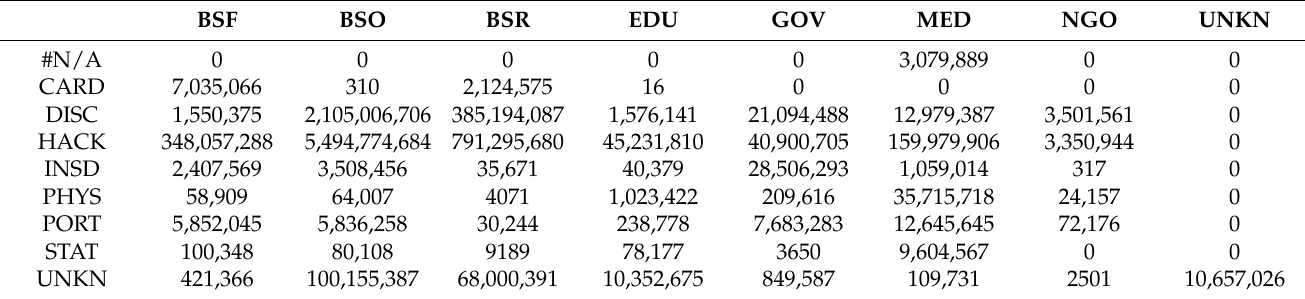
Table 4. Number of breached